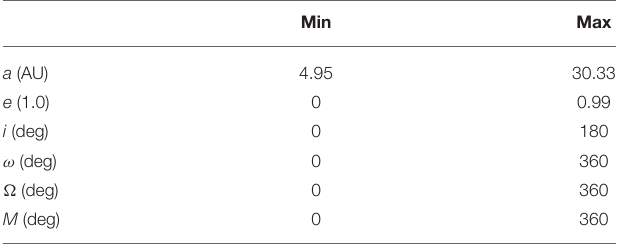
TABLE 1 | Parameter space for random initial conditions of the test particles. Min